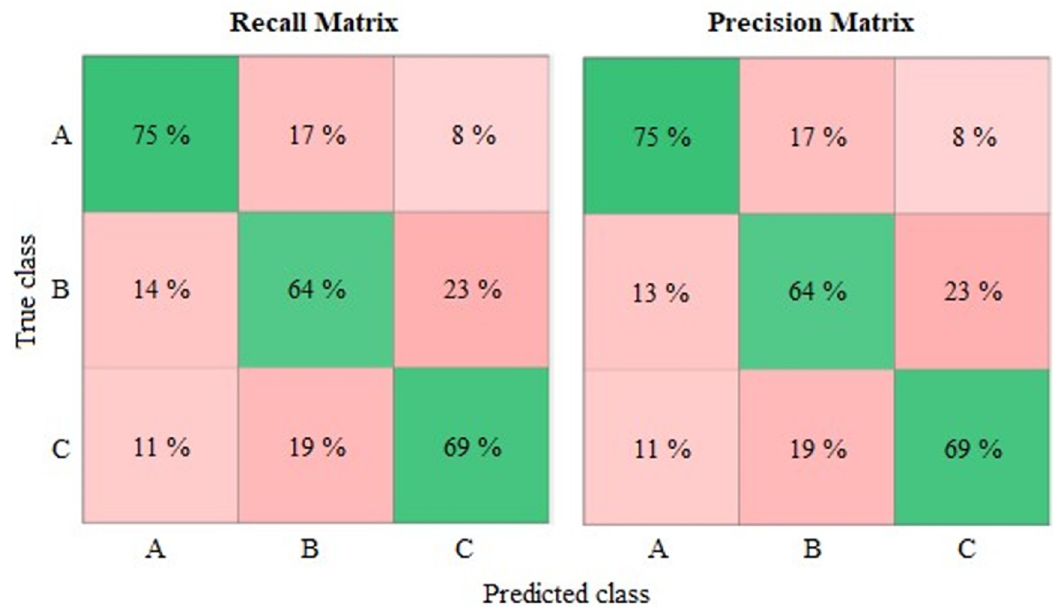
Figure 5. Confusion matrices of Predictive Model 141 for average surface roughness, Ra.